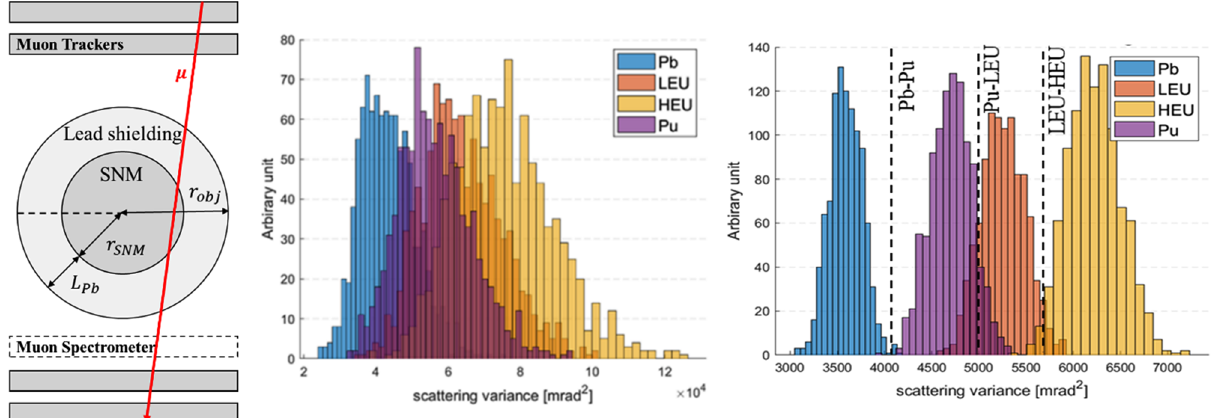
Figure 8. Muon scattering angle variance distributions. Schematic drawings of the SNM monitoring using cosmic ray muons (left). Scattering angle variance distribution for HEU, LEU, Pu, and Pb using 10 3 muon samples (it can translate to ~ min of scanning time) without (center) and with (right) muon momentum knowledge. By measuring muon momentum, we can separate lead from SNMs and identify each type of SNM even when they are surrounded by thick lead shielding (L Pb = 30 cm) 18